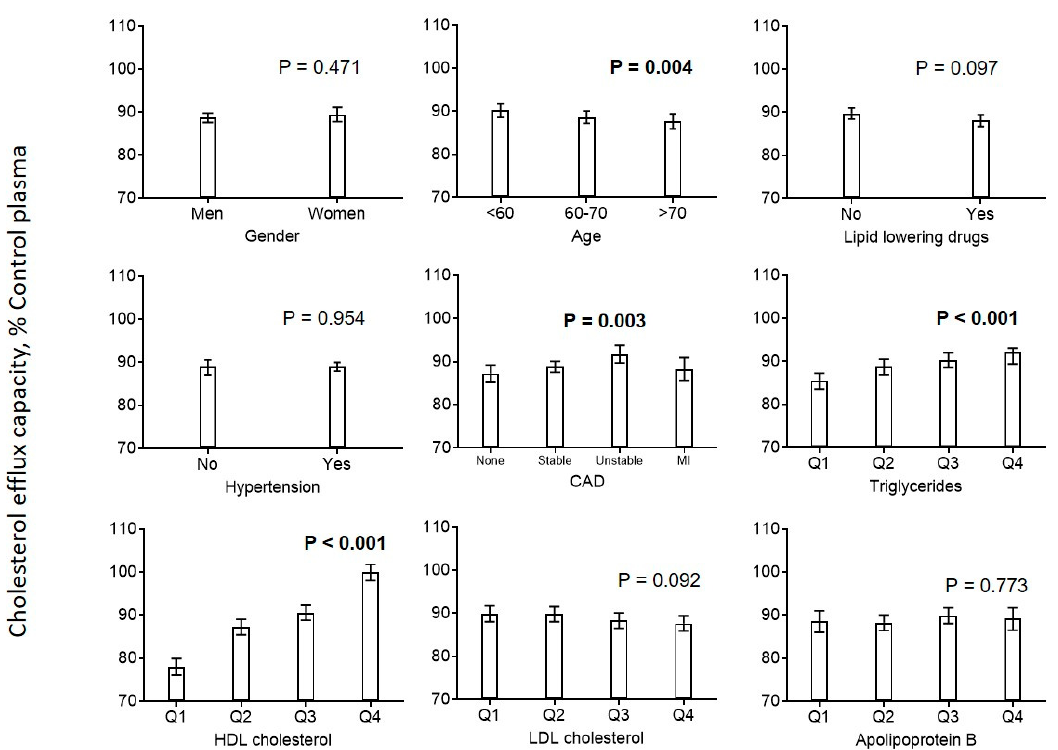
Figure 1. Association of cardiovascular risk factors with cholesterol efflux. Diagrams show the estimated marginal means with 95% confidence intervals obtained from a general linear model adjusted for use of statins, age, CAD, diabetes mellitus, smoking, LDL cholesterol, HDL cholesterol, and triglycerides. Age, LDL cholesterol, HDL cholesterol, and triglycerides (log-transformed) were included as continuous rather than categorical covariables. p values are given for comparison with the first category of each variable. p values < 0.05 are shown in bold. CAD = coronary artery disease.